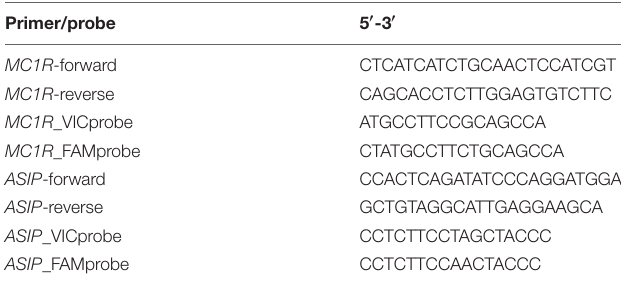
TABLE 2 | TaqMan assays for genotyping MC1R g901C > T and ASIP g.174495T >